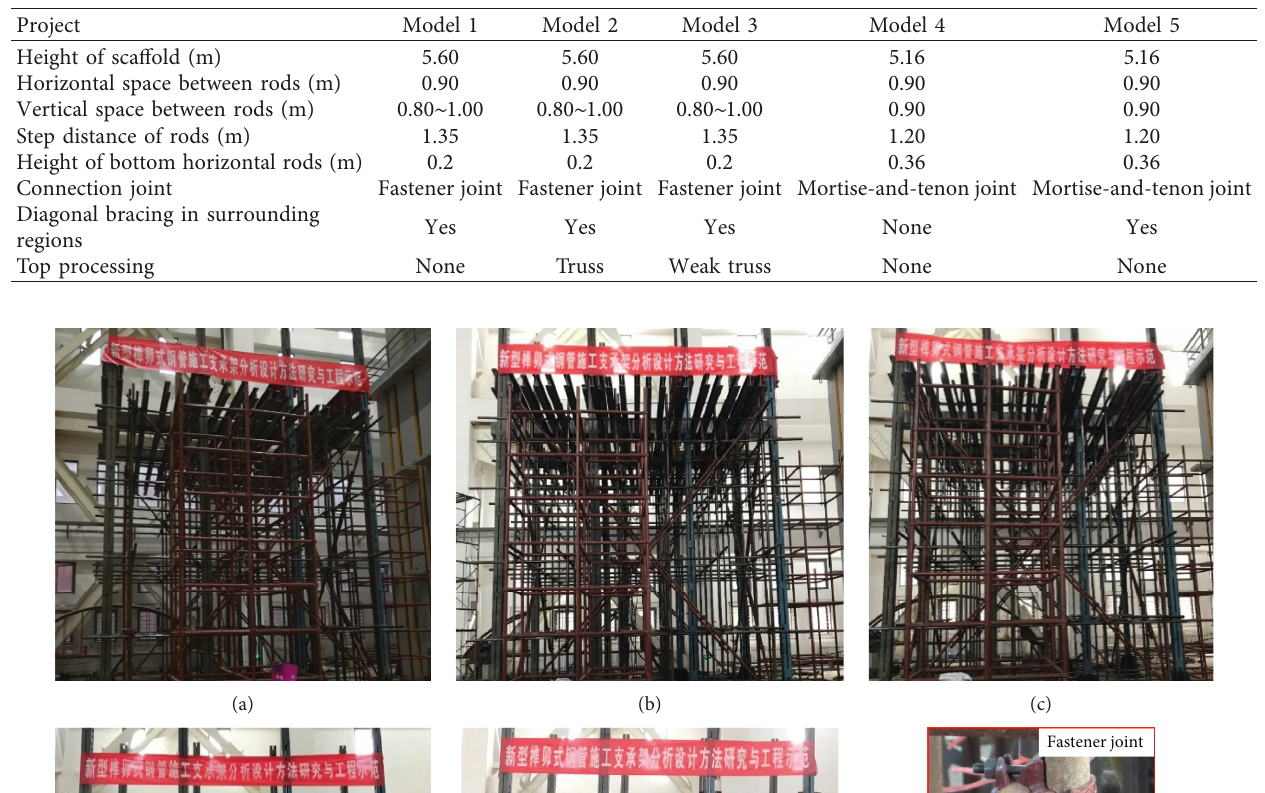
Table 1: Size of test models.